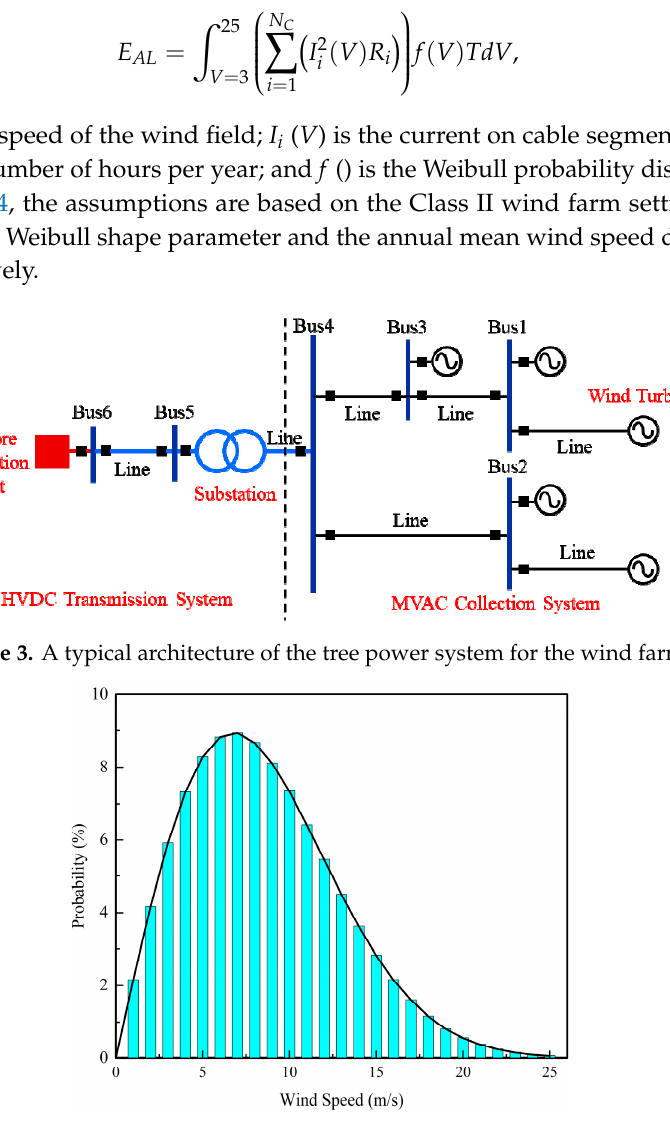
Figure 3. A typical architecture of the tree power system for the wind farm.